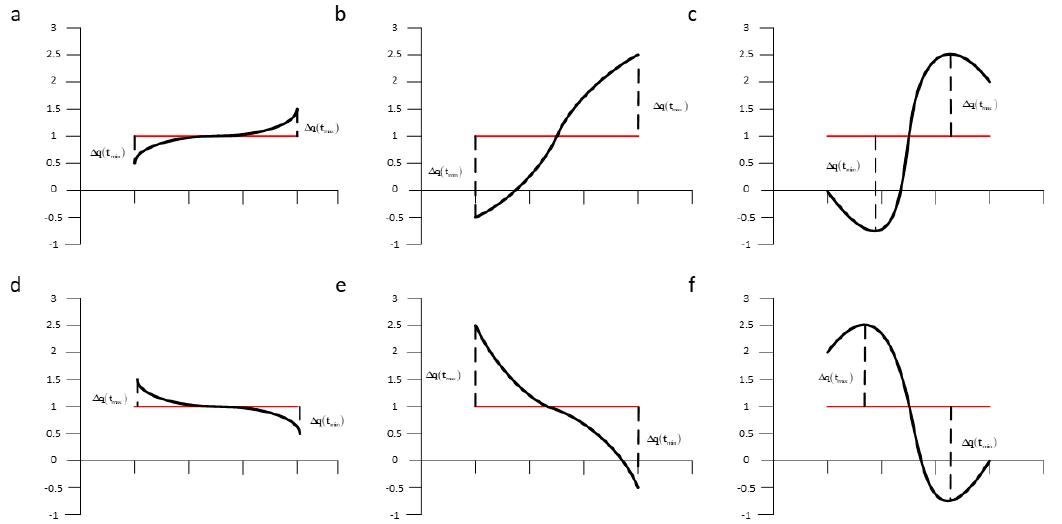
Figure 4. Several typical segments with the same average value but boundary distance. Segment a and d , b and e , c and f are in opposite directions while all in same mean value. The trend distance is replaced by boundary distance.